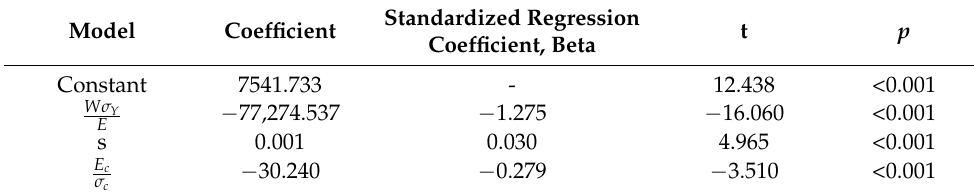
Table 19. Coefficients of the regression model for slurry pot test.